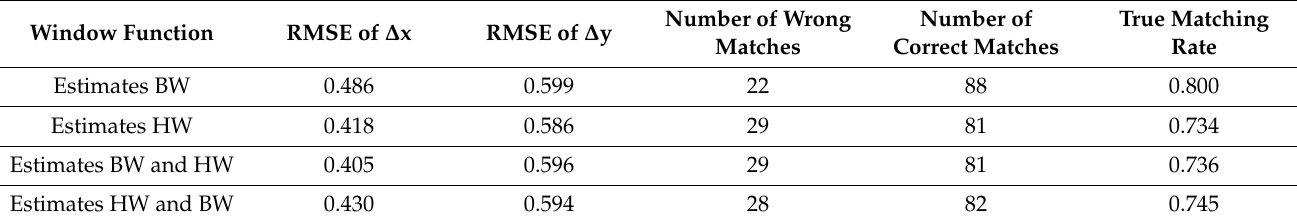
Table 3. Statistics of the matching errors using Blackman and Hann window functions, expressed in pixels. BW: Blackman window; HW: Hann window; BW-HW: reference patches weighted with BW and sensed patches weighted with HW; and HW-BW: reference patches weighted with HW and sensed patches weighted with BW.